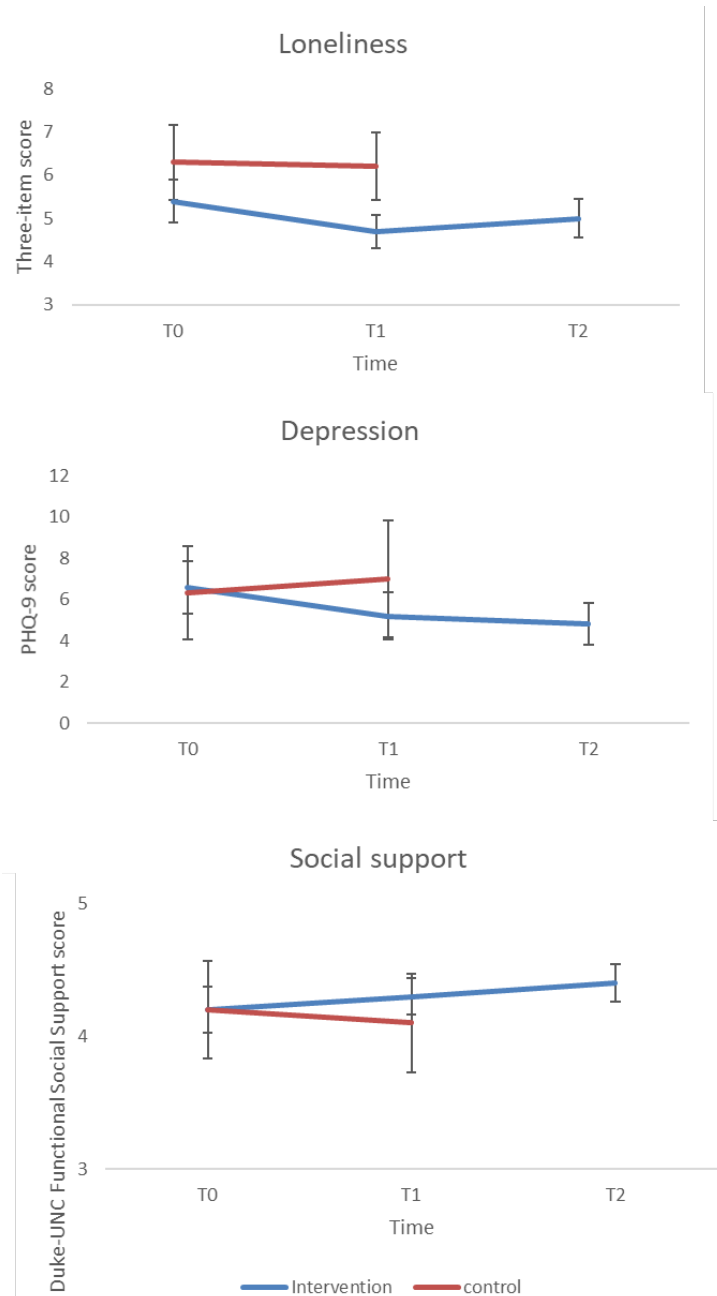
Figure 2. Outcomes measures of loneliness, depression (PHQ), and social support scores from baseline measurement (T0), end of program (T1) and 1-month follow-up (T2) in the intervention group and the wait-list control group. The graphic presents mean values and 95% confidence interval.